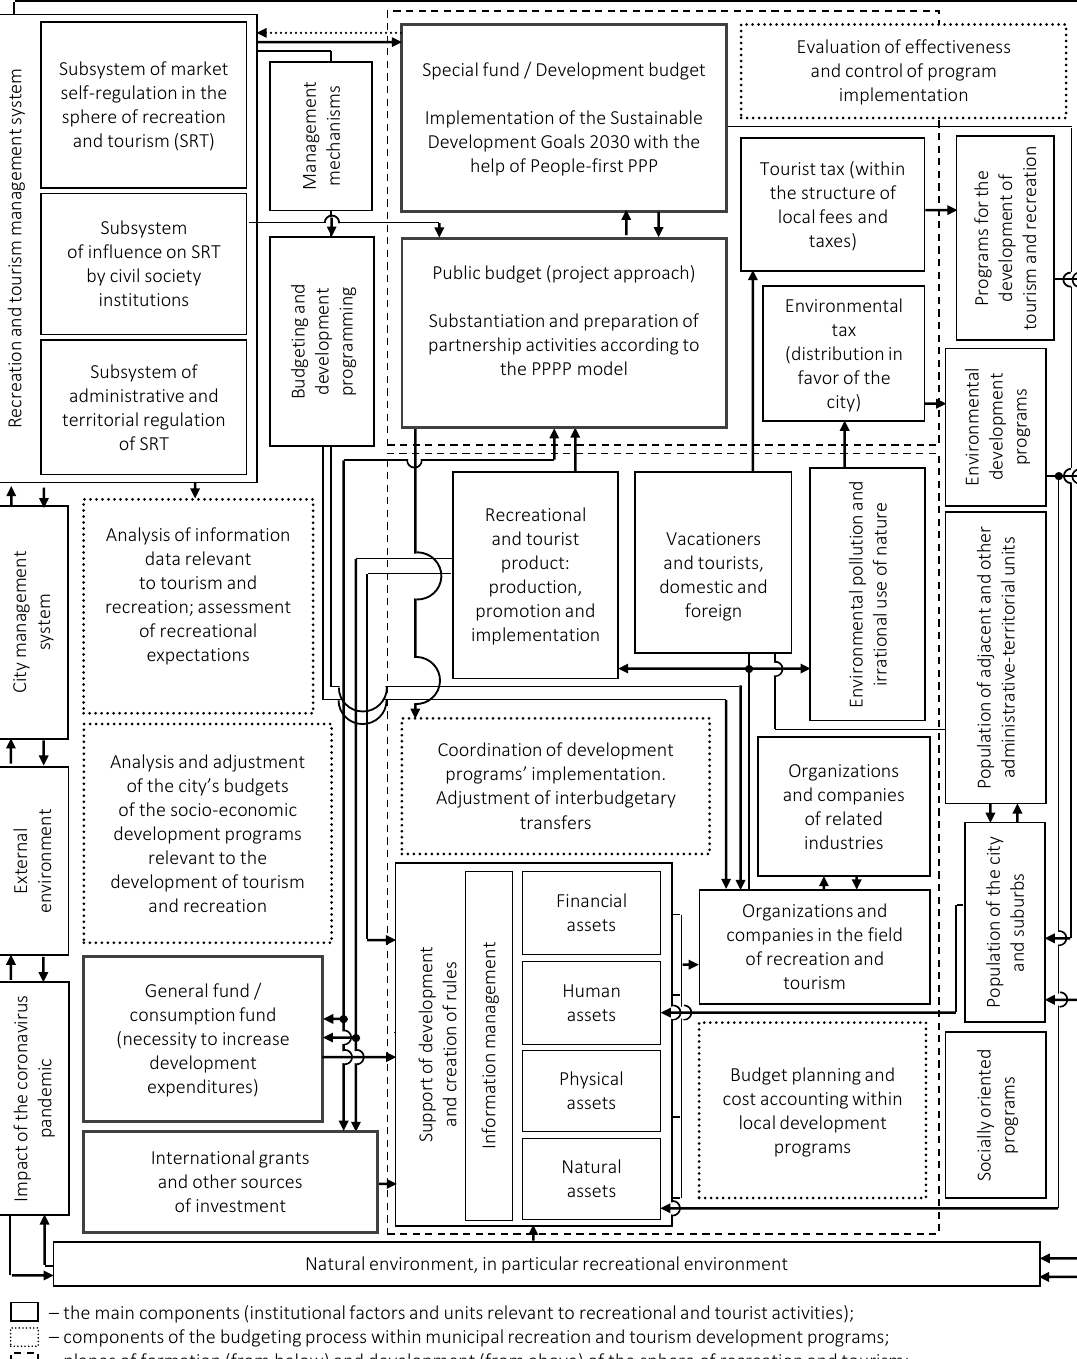
Figure 1. The budgeting mechanism within the framework of programs for the